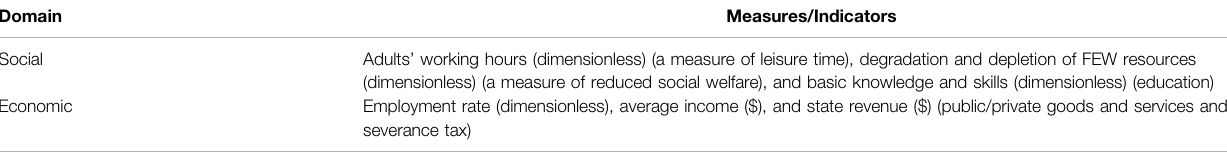
TABLE 2 | Domains and measures/indicators of human well-being (HWB). Domain Measures/Indicators